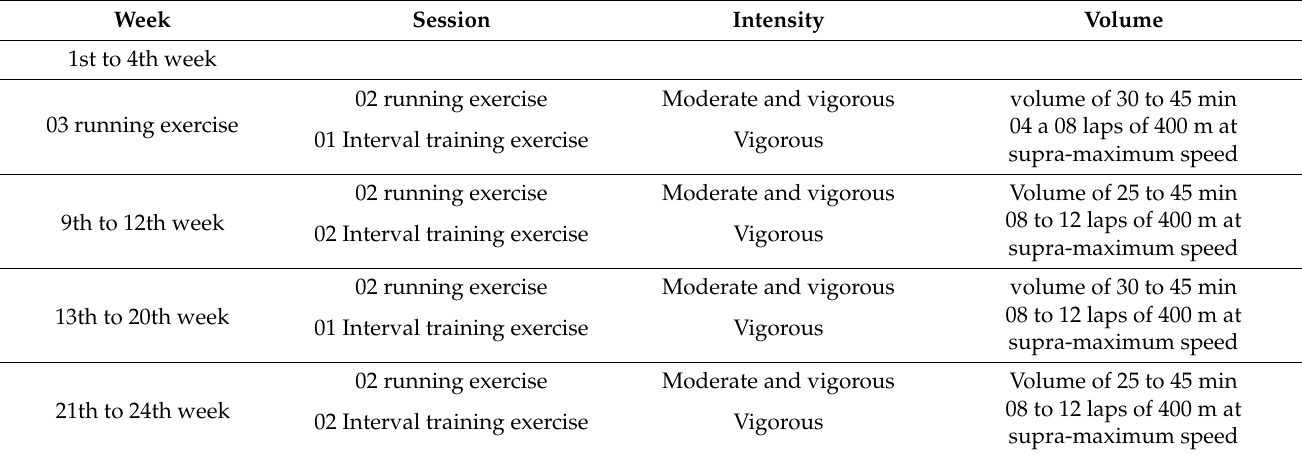
Table 1. Regarding cardiorespiratory running